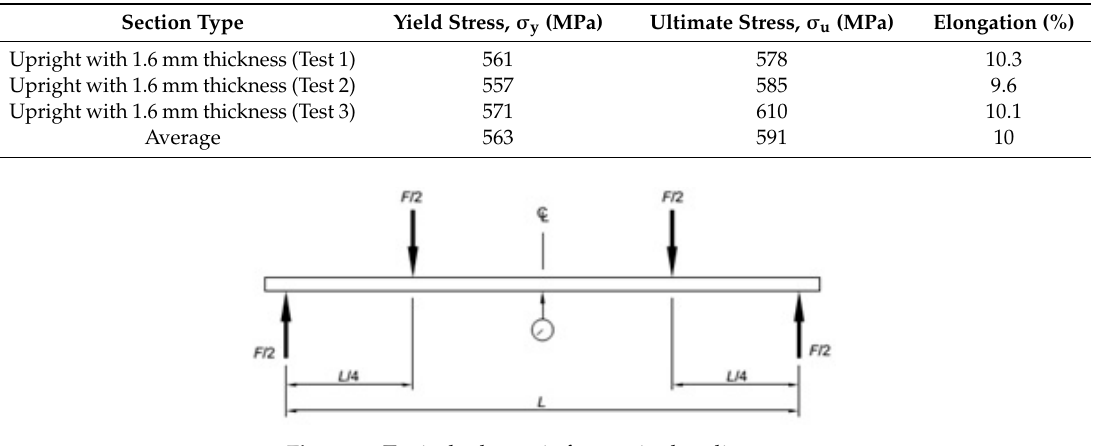
Figure 5. Typical schematic four-point bending test.